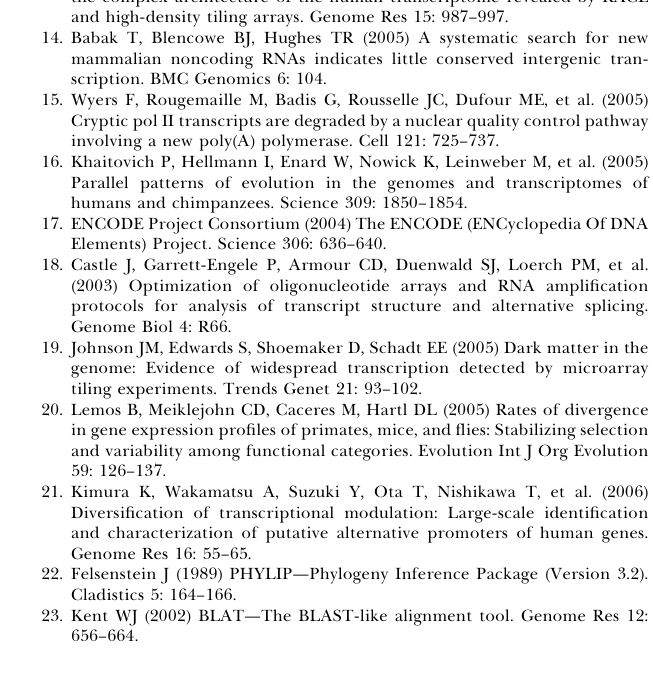
Figure S10. Expression Divergence and Divergence-to-Diversity Ratio in the Three Tissues for Low-Intensity Signals Shown are average expression divergence (A) and divergence-to- diversity ratio (B) between humans and chimpanzees in brain (yellow), heart (blue), and testis (red) for exonic and intergenic probes with a signal intensity lower than 50 in both species. The colored areas indicate 95% confidence intervals based on bootstrapping 1,000 subsets of exonic and intergenic probes. The darker shades indicate expression on the positive DNA strand, while the lighter shades indicate expression on the negative DNA strand. The symbols represent the mean value for the tissue on either the positive ( D ) or the negative ( * ) strand. Table S1. Sample Information Table S2. Numbers of Probes Classified as Expressed Table S3. Expression Divergence and Divergence-to-Diversity Ratios Table S4. Numbers of Probes Classified as Differently Expressed Table S5. Coordinates of Probes with Significant Expression Differ- ence between Humans and Chimpanzees (Student’s t -test p , 0.001, FDR , 0.05)